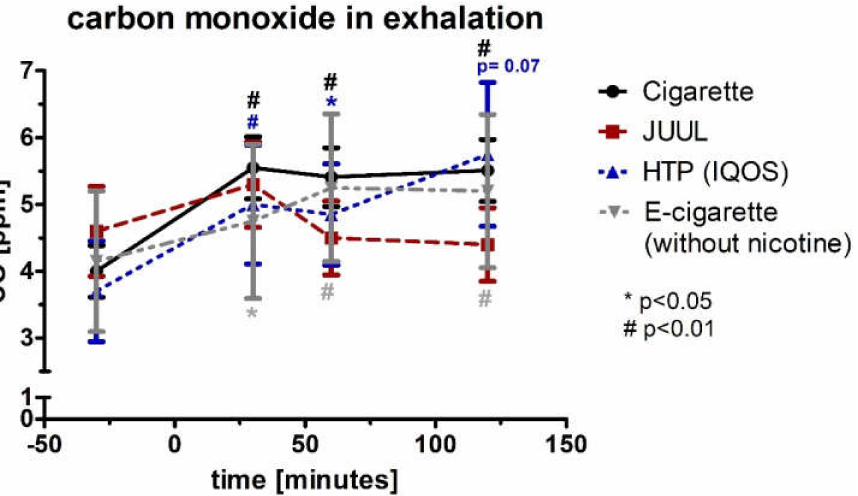
Figure 2. Concentration of carbon monoxide in exhaled air before and after consuming the cigarette, JUUL TM , heated tobacco product, and e-cigarette without nicotine.